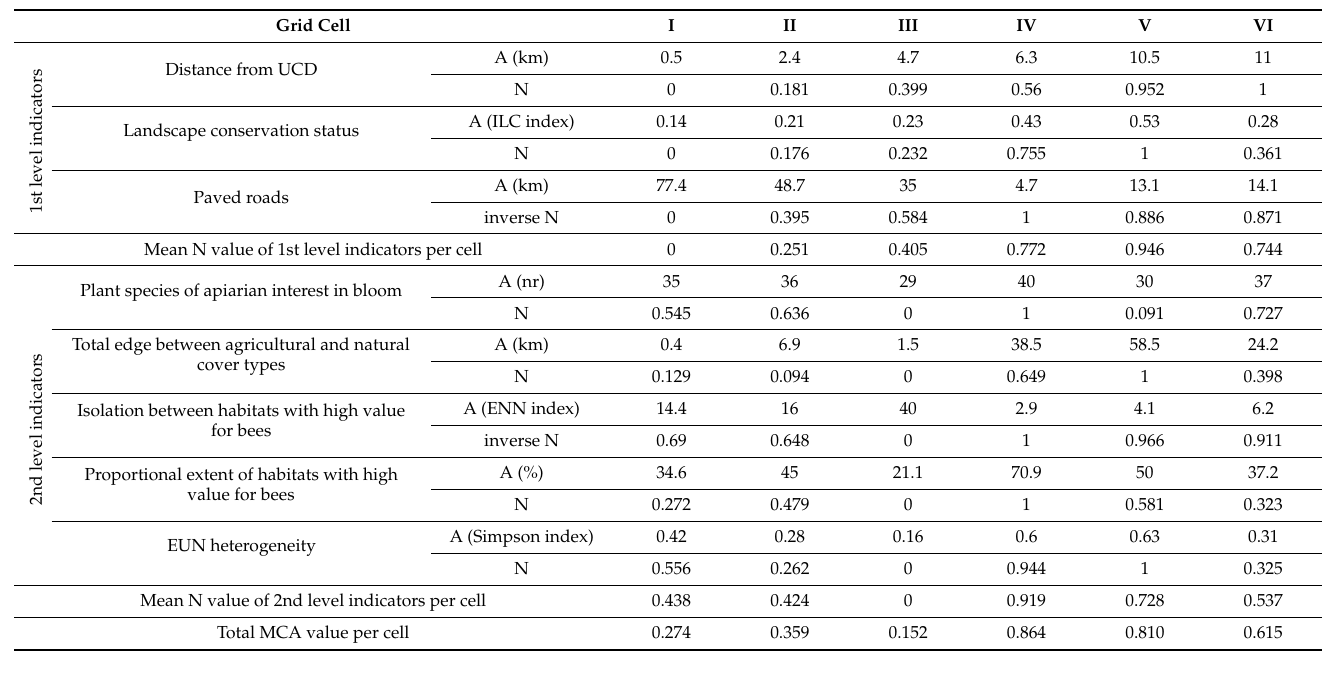
Table 6. Varying capacity to support pollinators across the grid cells according to the MCA. Absolute (A) and normalised (N) values of the first-level and second-level selected indicators.